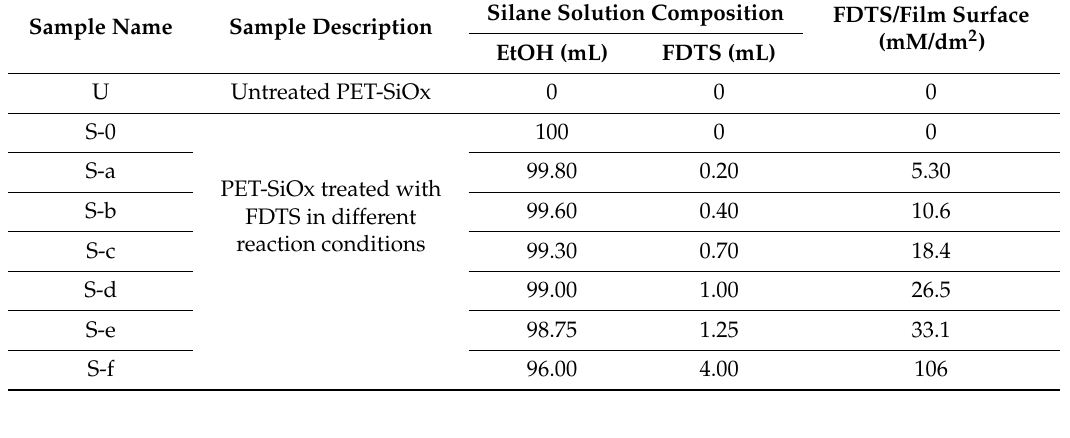
Table 1. Sample description and nomenclature.